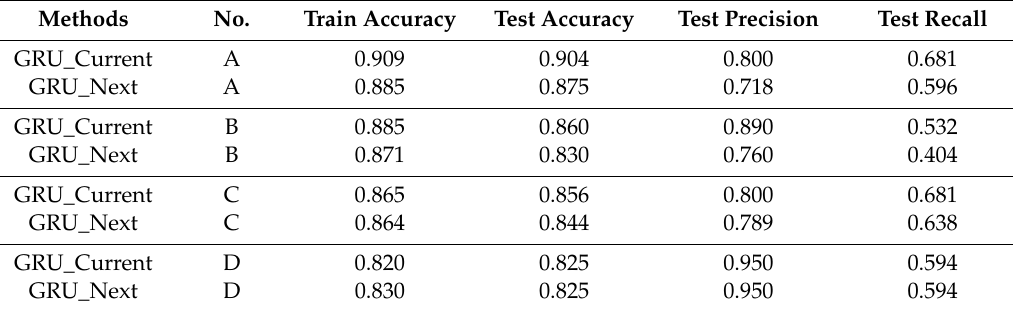
Table 5. Comparisons between two